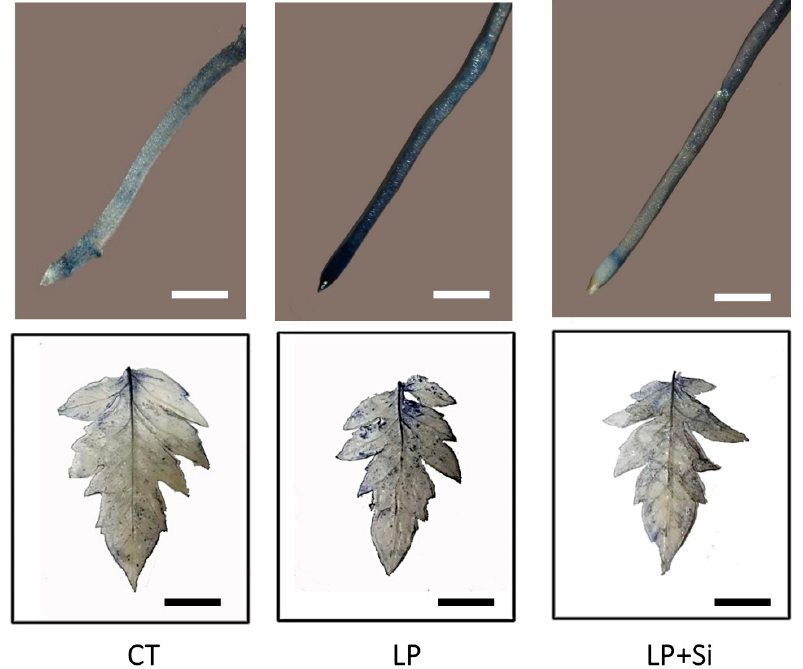
Figure 2. In situ superoxide (O 2 − . ) accumulation in tomato roots and leaves as influenced by low phosphorus (LP) and exogenous silicon (Si): O 2 − . accumulation was visualized following nitroblue tetrazolium chloride (NBT) staining. NBT-stained roots (upper panels) and leaves (lower panels) show localized O 2 − . accumulation as dark-blue spots under different treatments. Scale bars = 2 mm (upper panels) and 2 cm (lower panels).